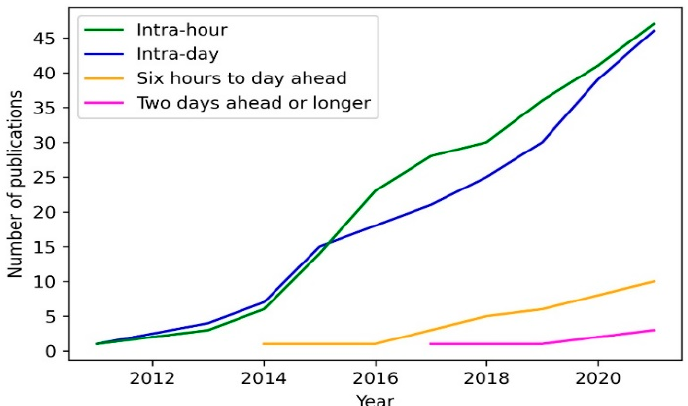
Figure 3. Cumulative evolution of the number of publications addressing a given forecast horizon range.